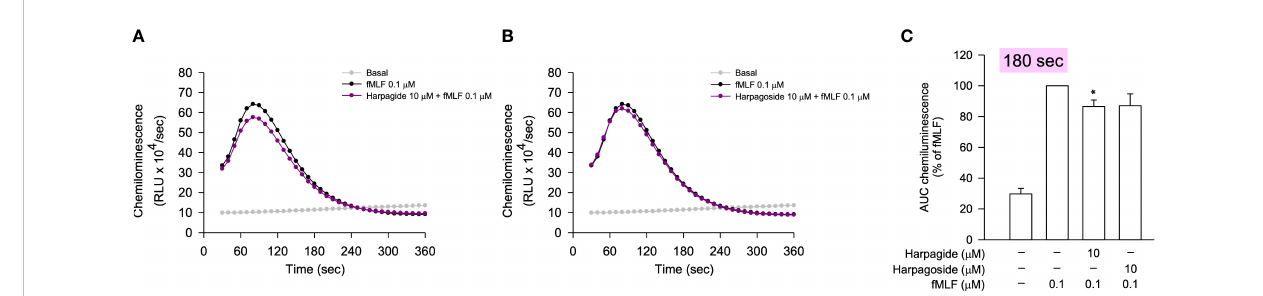
FIGURE 7 The compounds from the non-bioactive MIMN clusters did not signi fi cantly affect the fMLF-induced ROS generation in human neutrophils. (A, B) The luminol-mixed human neutrophils were incubated with DMSO (0.1%, as the control) or compounds (0.001 – 10 m M) and were activated by fMLF (0.1 m M). ROS production was detected by a chemiluminometer. The AUC value was quanti fi ed and shown in (C) . The values were shown as the mean ± S.E.M. (n = 3 – 4). * p < 0.05, compared with the stimulated control.